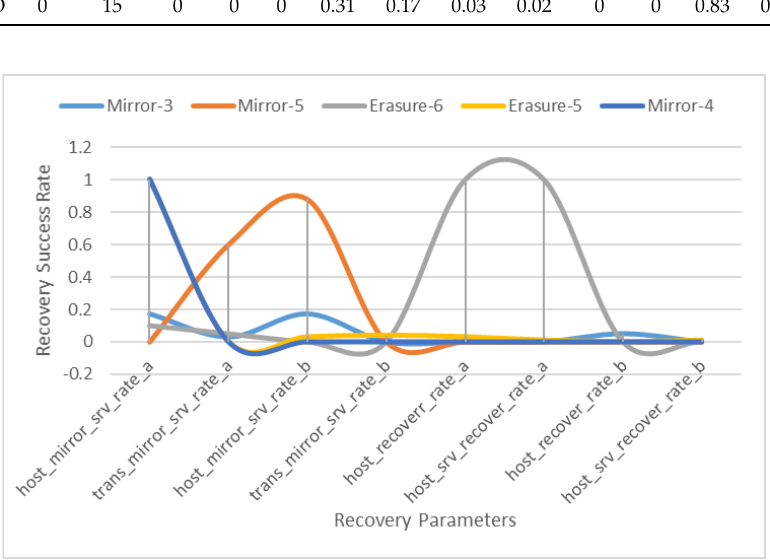
Figure 3. Training Results.